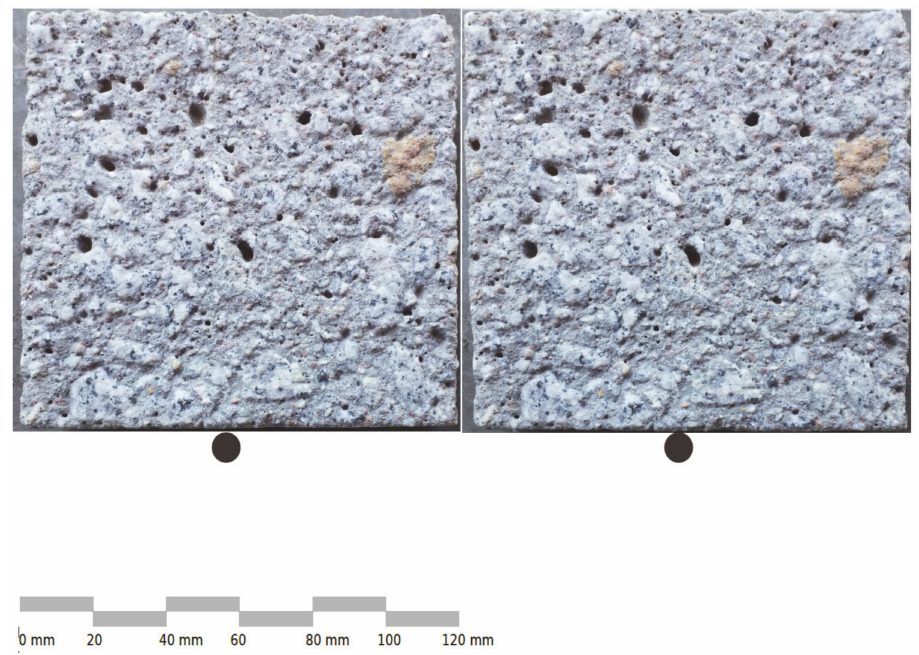
Figure 4. Stereoscopic image of the sandblasted surface (together, the left and right images create a 3D e ff ect while keeping eyes as “looking into the distance”).